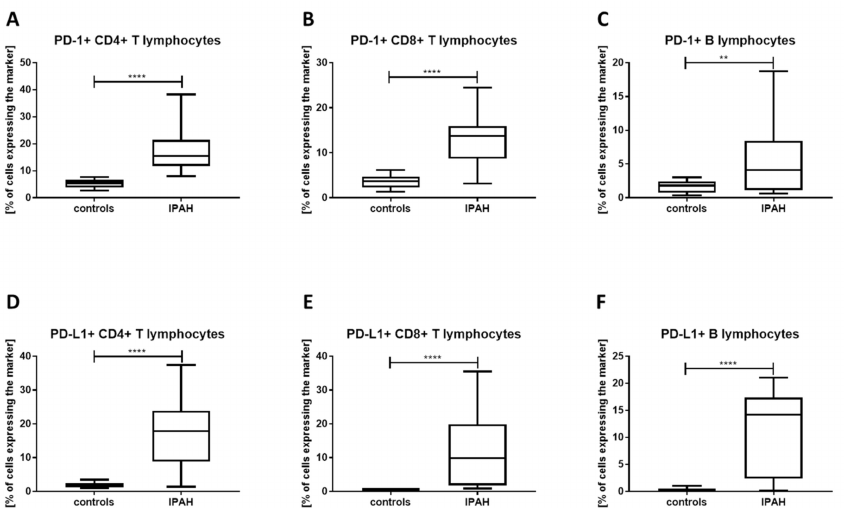
Figure 2. PD-1 and PD-L1 are overexpressed on T and B cells of IPAH patients. Expression of PD-1 and PD-L1 was assessed on B cells, CD4 + , and CD8 + T cells. CD4 + T cells, CD8 + T cells, and B cells expressed ( A – C ) PD-1 and ( D – F ) PD-L1 markers at the significantly elevated levels in the IPAH patients’ blood. Horizontal bars represent medians; boxes overlap 25th to 75th percentiles, and whiskers extend from minimum to maximum. In the figure, ** denotes p ≤ 0.01 and **** p ≤ 0.0001.